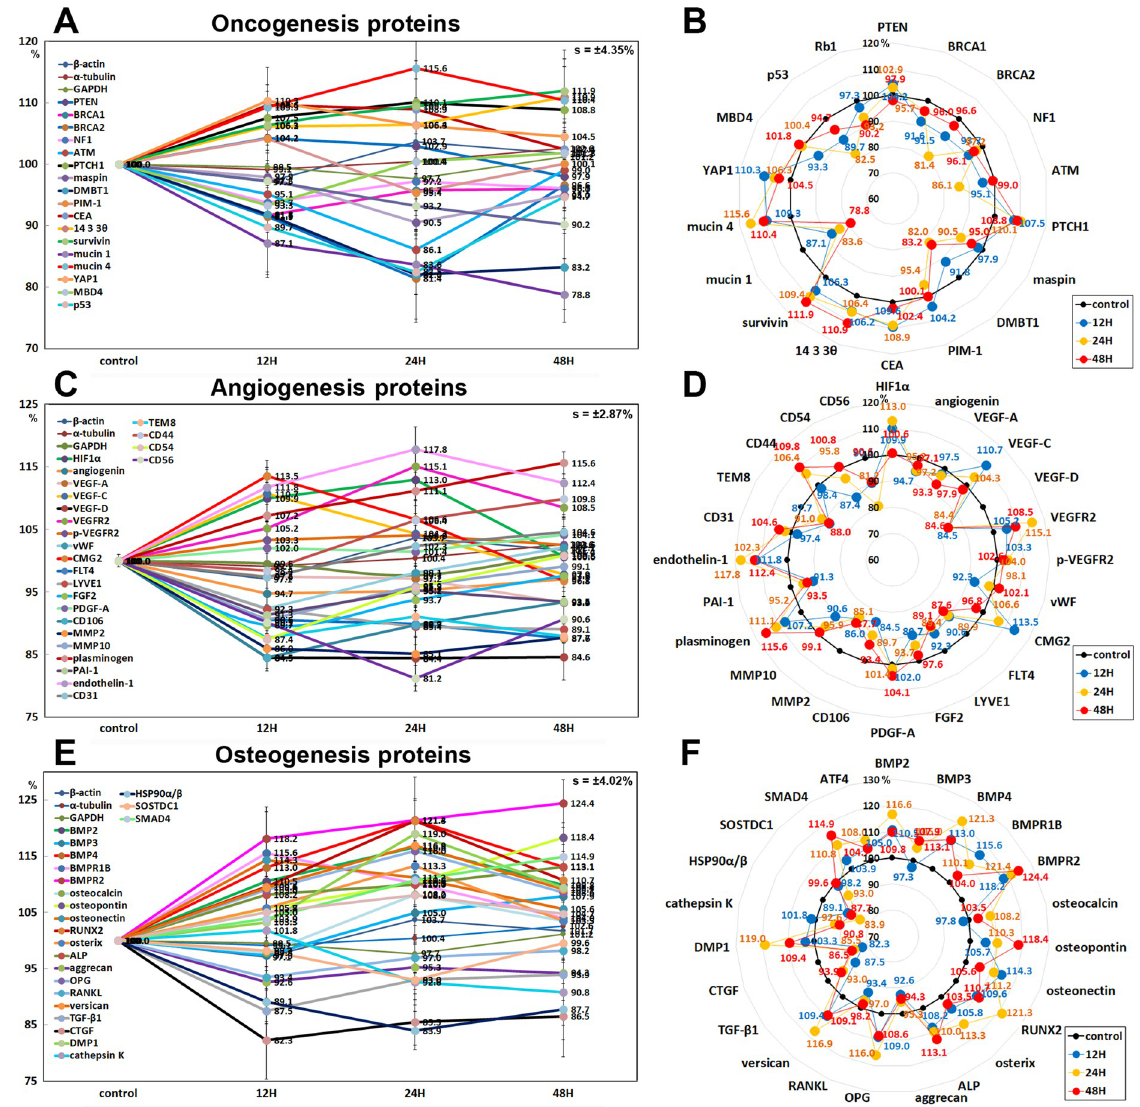
Fig 15. Expression of oncogenesis proteins (A and B), angiogenesis proteins (C and D), and osteogenesis proteins (E and F) in 10 μ g/mL PTX-treated RAW 264.7 cells as determined by IP-HPLC. Line graphs, A, C, and E show protein expression on the same scale (%) versus culture time (12, 24, or 48 h), whereas the star plots (B, D, and F) show the differential expression levels of the proteins at 12, 24, or 48 h after PTX treatment on the appropriate scales (%). The thick black line, untreated controls (100%); the blue, yellow, and red dots show differential protein levels after PTX administration for 12, 24, or 48 h,